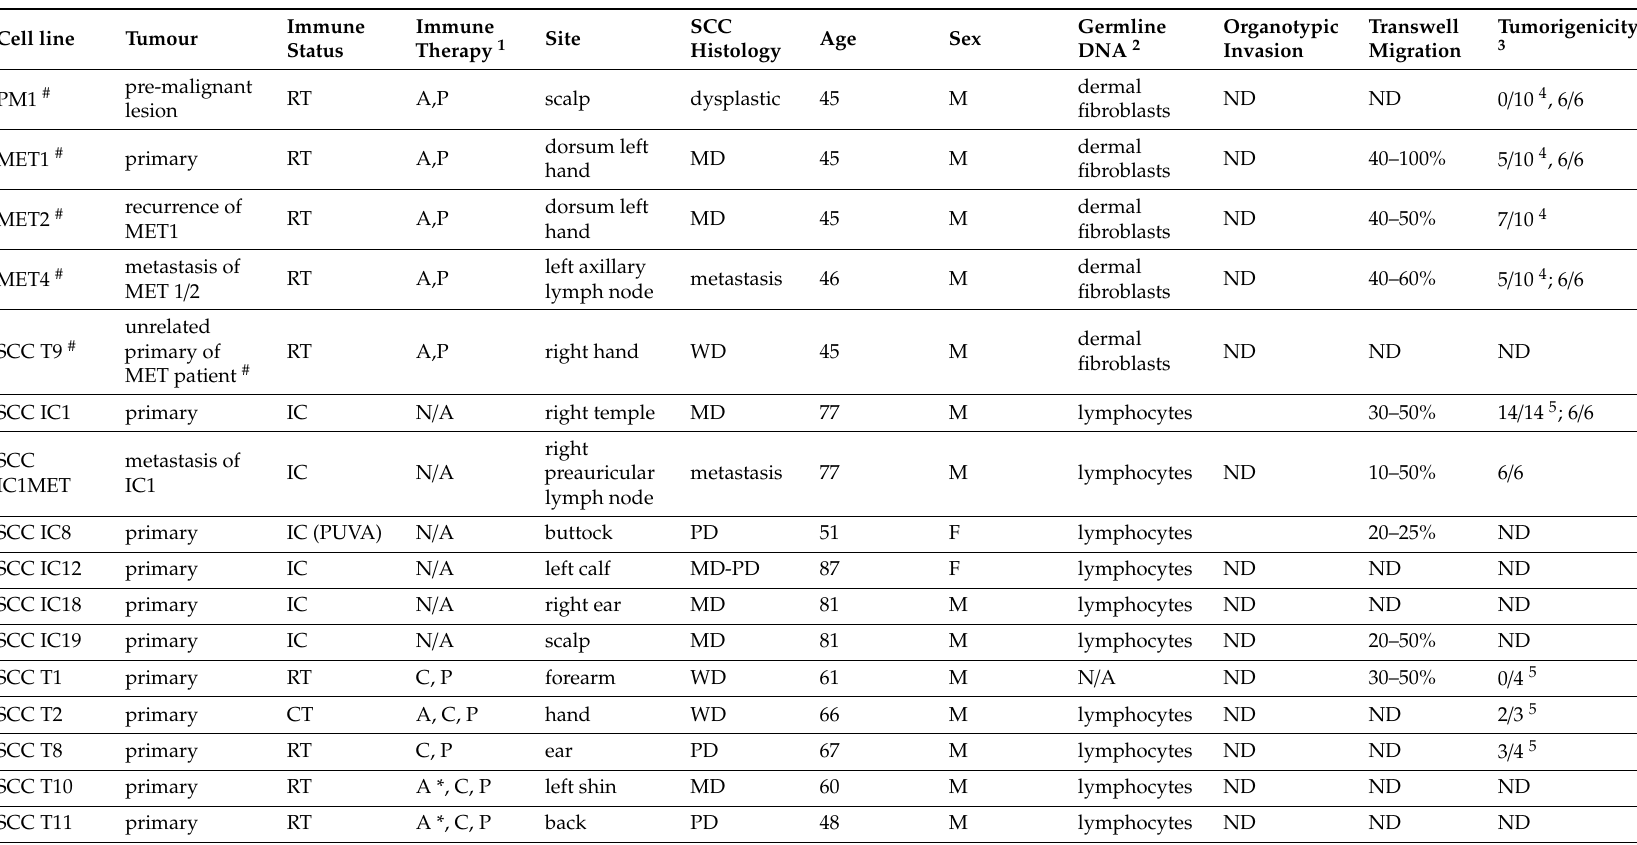
Table 1. Details of established cell lines, patient characteristics, immune therapies, histopathological status, and identification of in vivo and in vitro tests. Cell